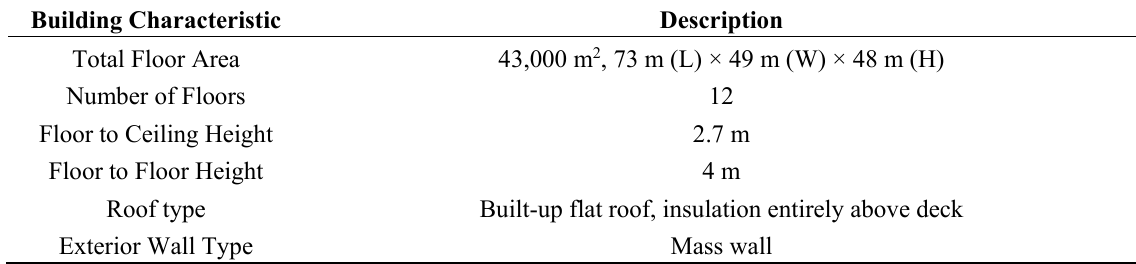
Table A1. Common building information for both reference building model and the GB 50189 code compliant building